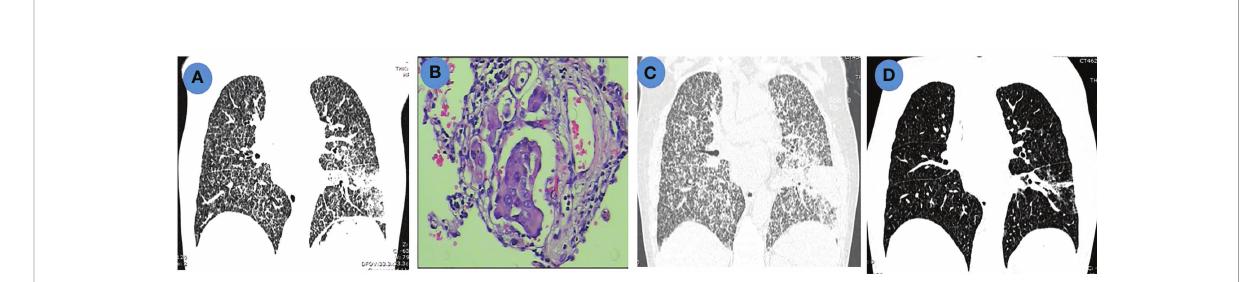
FIGURE 5 Chest imaging and pathological features in a patient with PLC. (A) . Chest CT scan shows pulmonary mass with diffuse PLC before chemotherapy; (B) . Hematoxylin and eosin (H&E) staining (200×) of lymphatic tumor embolus; (C) . Chest CT scan shows progressive disease (PD) after chemotherapy; (D) . Chest CT scan shows partial remission (PR) after anlotinib